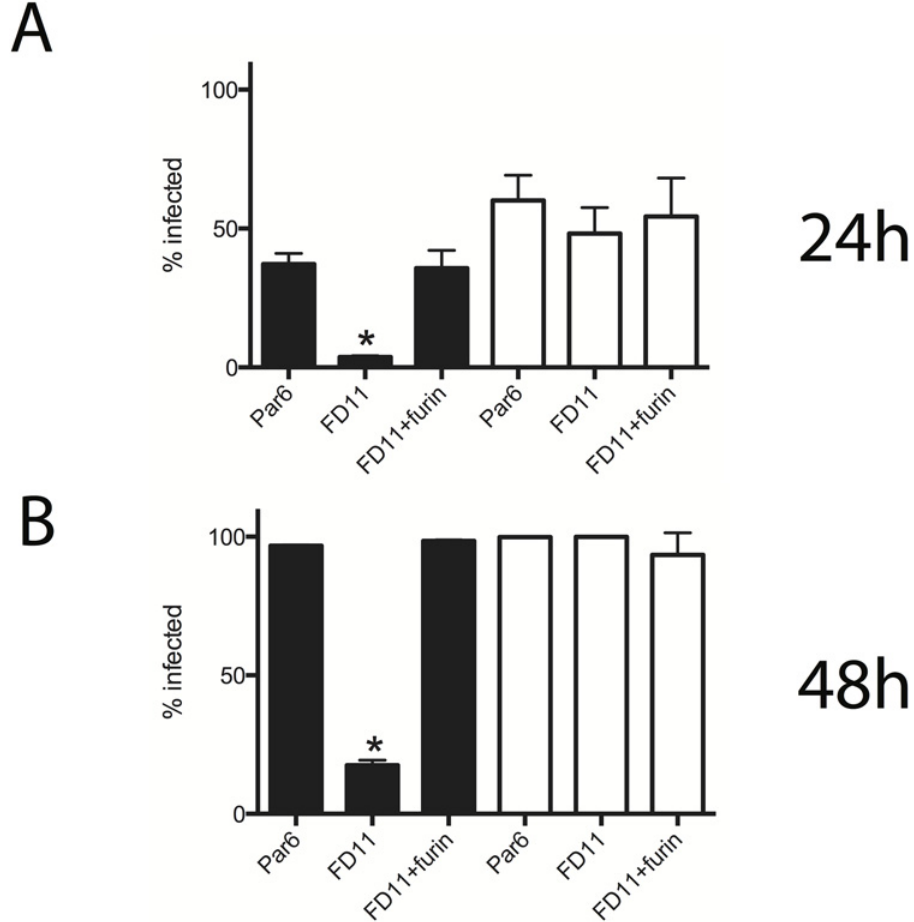
at multiplicity of infection (MOI) = 1 or with Rift Valley fever virus expressing EGFP in place of NSs (RVFV-EGFP; MOI = 0.1). Percentage of infected cells was determined by immunostaining for CCHFV, or by EGFP detection for RVFV at 24 h (A) and 48 h (B) post infection. Black bars represent CCHFV-infected cells; white bars represent RVFV-infected cells. Error bars indicate means ± standard deviation (n = 3).